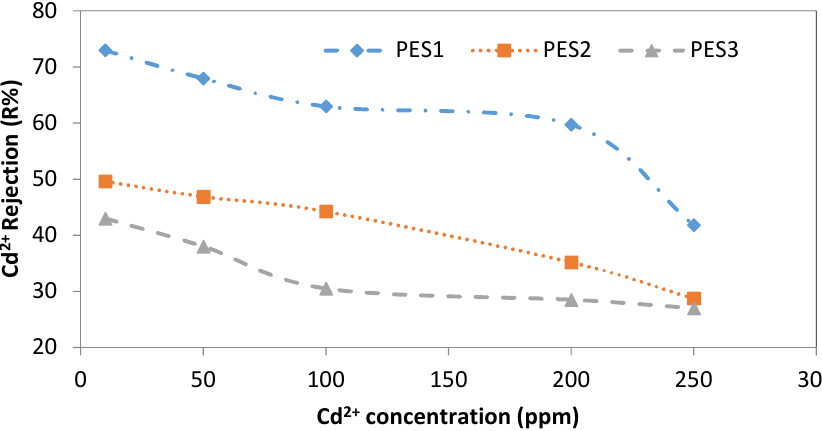
Figure 10. Effect of initial Cd 2+ concentration on Cd 2+ rejection using PES1, PES2, and PES3 membranes (experimental conditions: pH = 6 ± 0.2, transmembrane pressure of 1 bar).